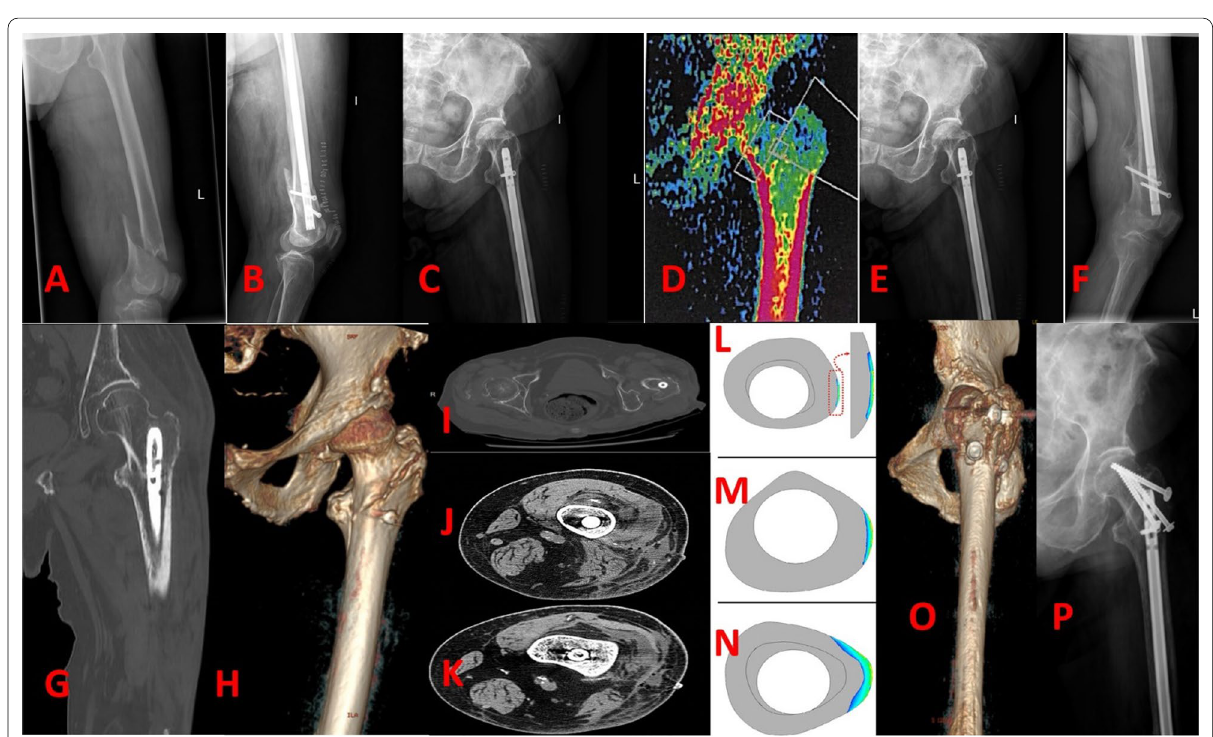
Fig. 4 Forty-eight-year-old female patient sustaining a distal third femoral fracture ( A ). Surgical treatment of the same patient with blocked retrograde intra-medullary nail ( B , C ). DEXA scan 1 year after surgery showing osteoporosis at the level of the trochanters and femoral diaphysis ( D ). Femur X-ray 1 year after surgery shows femur demineralization of the proximal femoral third ( E ) and complete fracture union at the distal femoral third ( F ). Two months after the latest follow-up visit, the patient presented to the local hospital after a fall, complaining of ipsilateral hip pain. Femur X-ray and CT scan highlighted an undisplaced intertrochanteric fracture ( G , H ). CT scan cuts at the level of the greater trochanter ( I ), isthmus ( J ) and condyles ( K ) are compared with biomechanical studies belonging to Shih et al. [22] ( L – N ) and show shielding of the nail with stress applied to the intertrochanteric area. The intertrochanteric fracture was surgically managed with three cannulated screws. 6 months post-operation X-ray and CT scan showed fracture union ( O , P